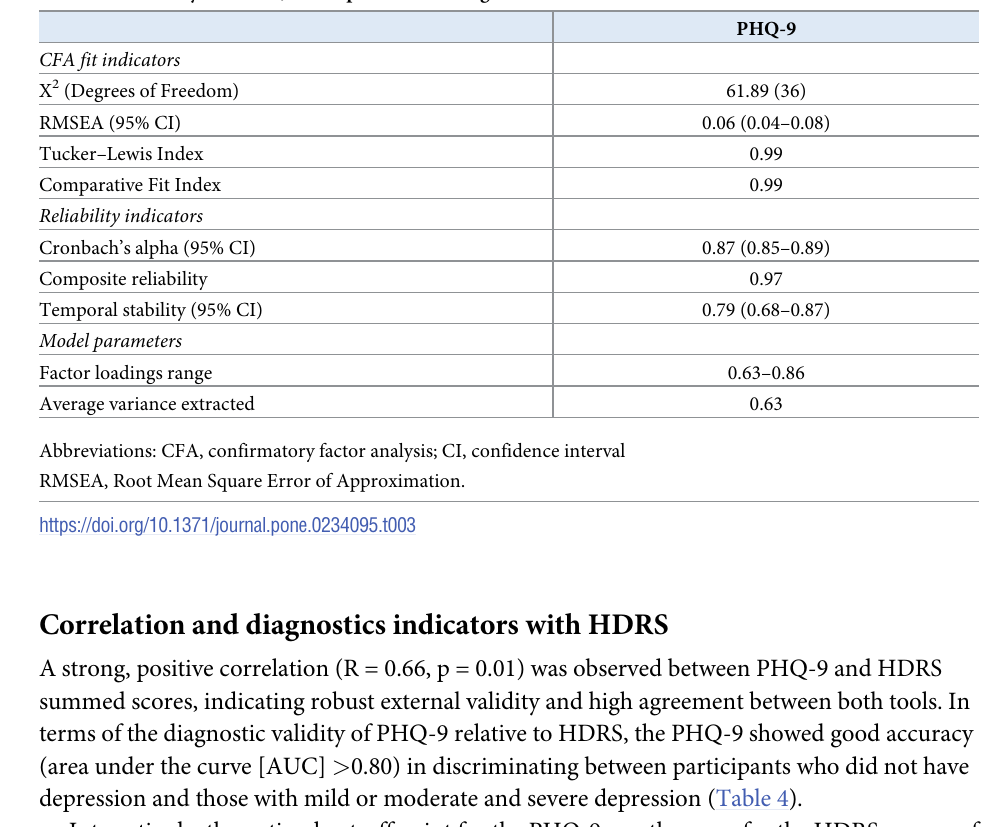
Table 3. Reliability measures, model parameters and goodness-of-fit indicators of the CFA model.